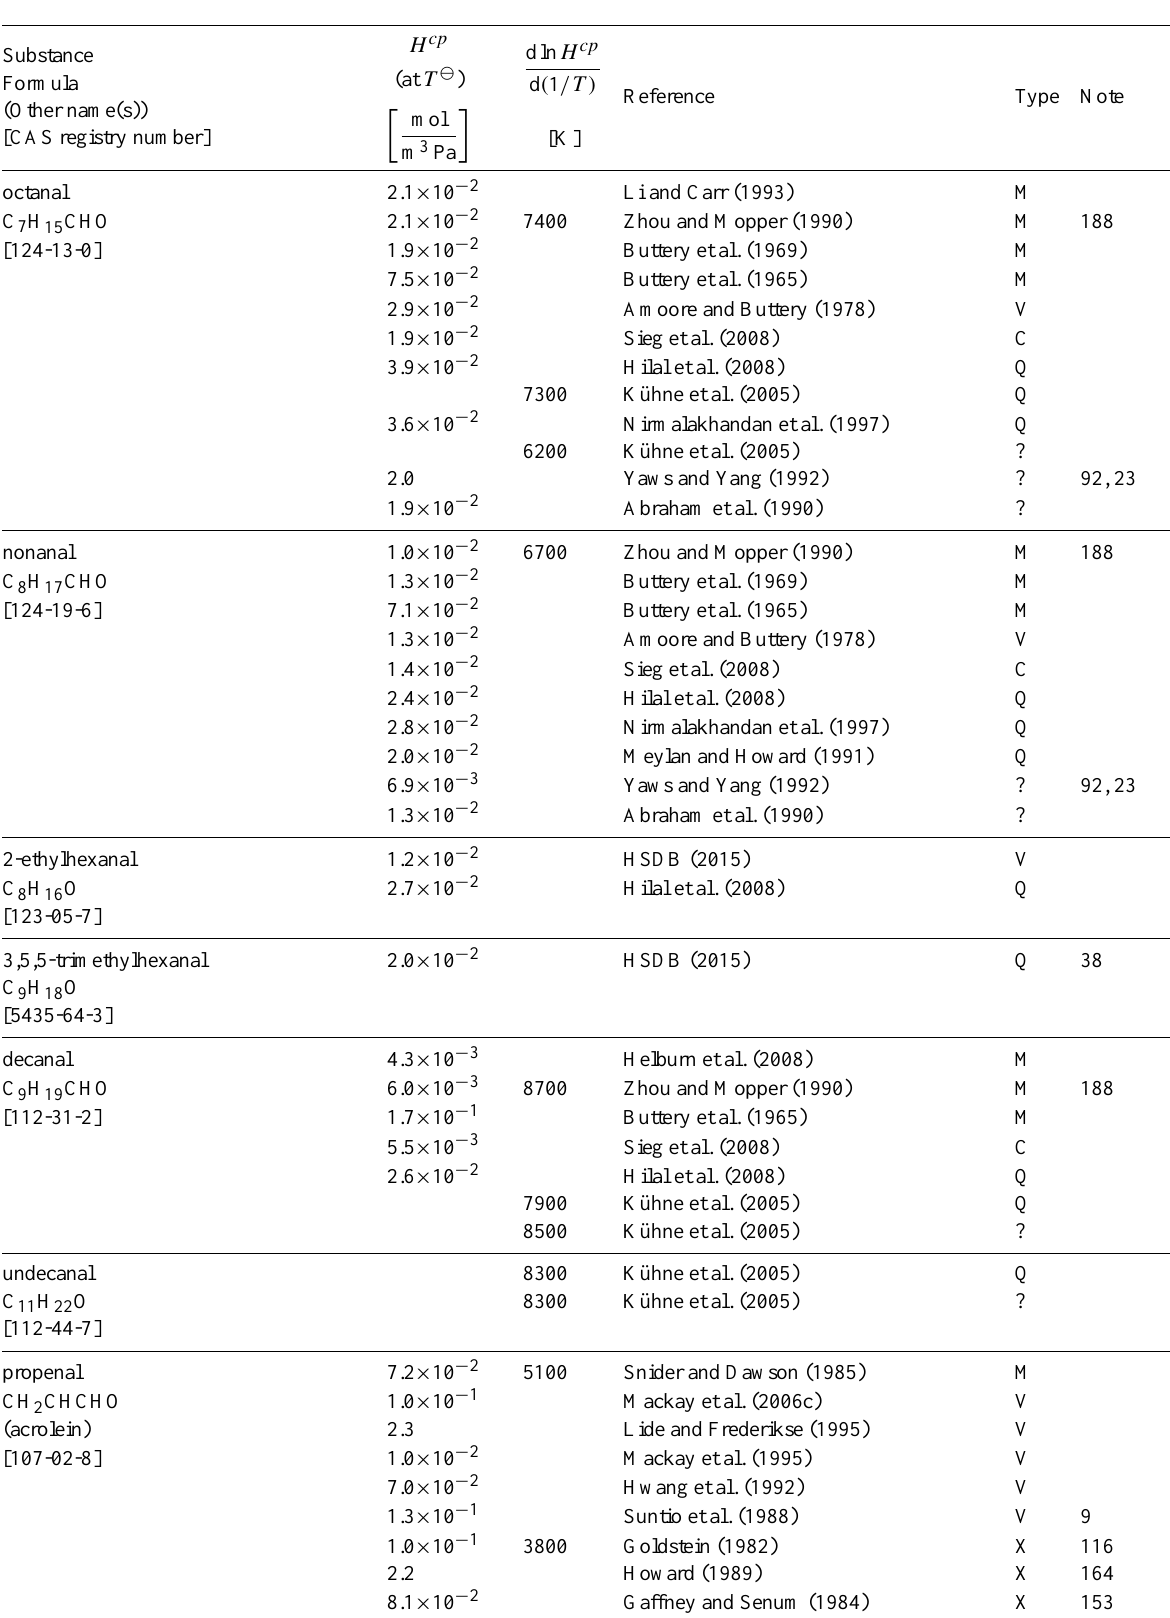
Table 6: Henry’s law constants for water as solvent